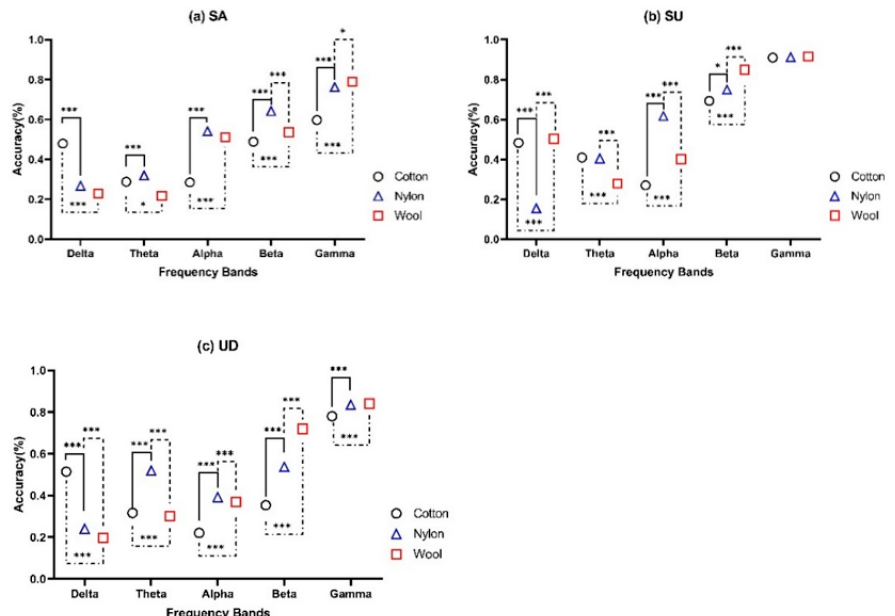
Figure 6. Comparisons of the classification accuracies of the SVM-ML model with respect to fabric stimulations when considering arm differences, i.e., ( a ) SA, ( b ) SU, and ( c ) UD. The significant differences are indicated by ‘*’ for p < 0.05 and ‘***’ for p < 0.001 (Kruskal–Wallis with Bonferroni post ‐ hoc test).